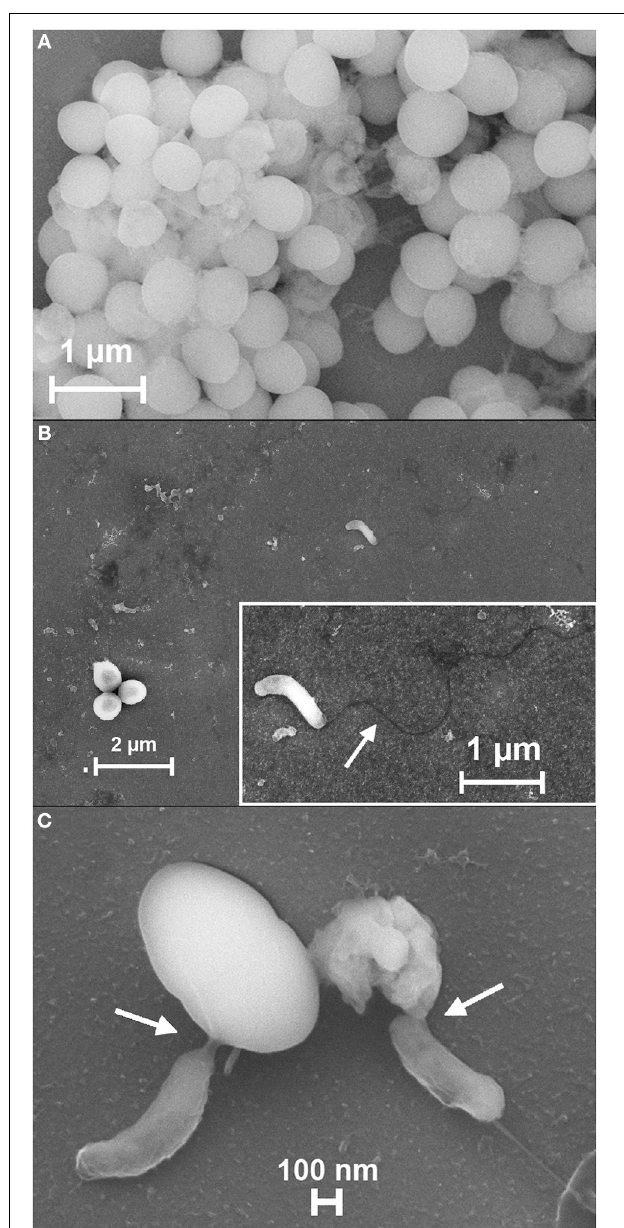
FIGURE 4 | Predation of B. bacteriovorus on “static” biofilm of S. aureus . s.e.m. images of S. aureus biofilm ( A , 30000X) grown for 24h on a silicon plate, and after 24h of B. bacteriovorus HD100 predation ( B , 20000X). A free Bdellovibrio is visible with its long polar flagellum (estimated length, 4 µ m) (arrow, B , inset, 50000X). A higher s.e.m. magnification (88830X) shows the initial attack phase of HD100 on a prey cell ( C , left) and the late attack phase, with a destroyed S. aureus cell ( C , right). White arrows in (C) show the direct interaction of B. bacteriovorus HD100 with S. aureus .